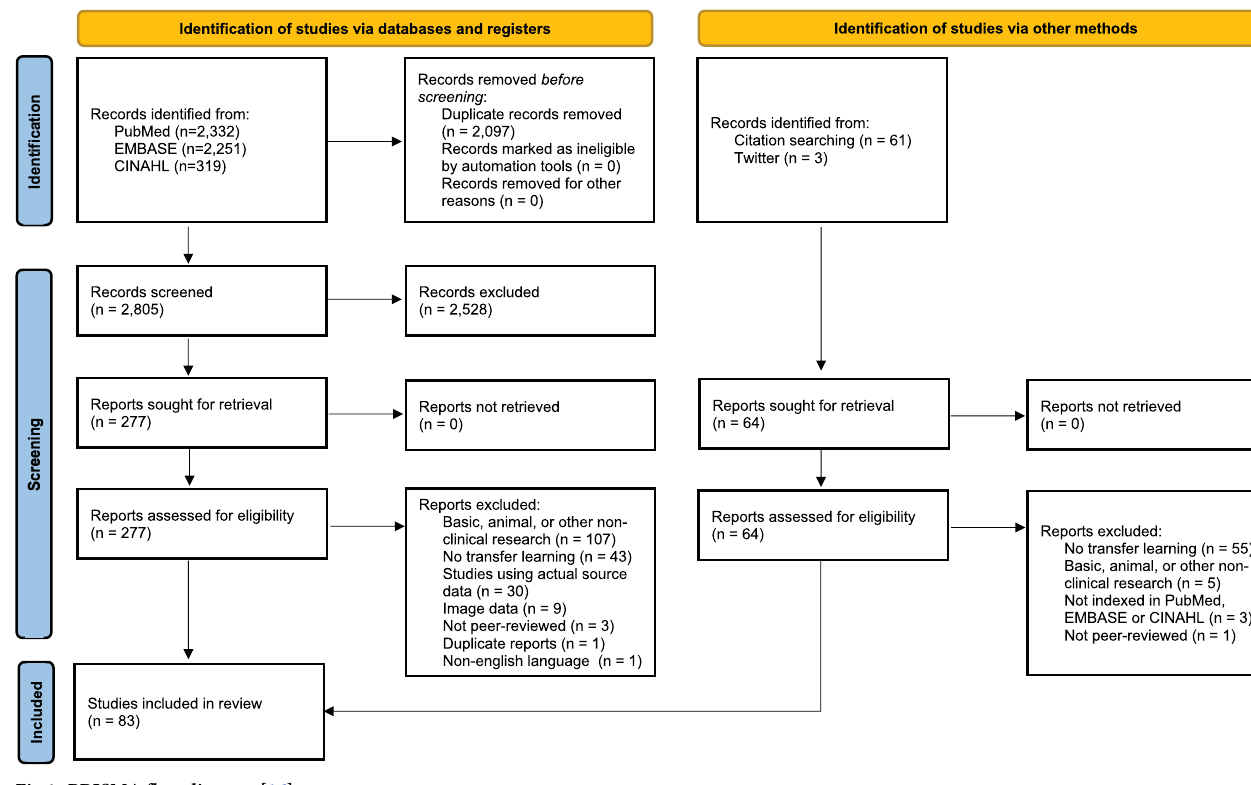
Fig 1. PRISMA flow diagram